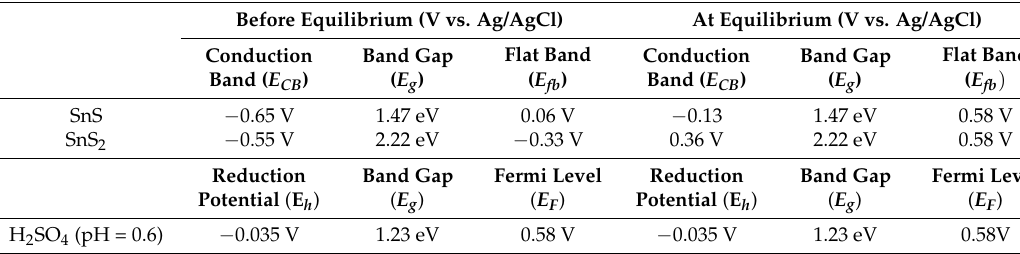
Figure 7. Schematic energy levels of SnS: ( a ) before; and ( b ) at equilibrium; and for SnS 2 : ( c ) before; and ( d ) at equilibrium. Table 1. The details of the band positions before and at equilibrium.